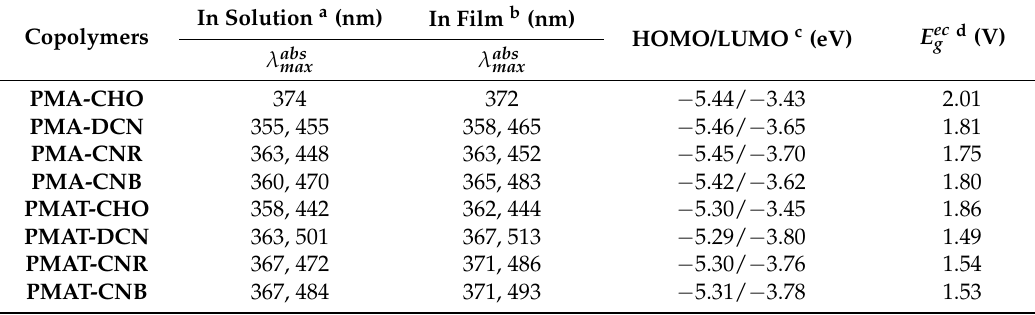
Figure 2. Ultraviolet (UV)-visible absorption spectra of the copolymers ( a ) in toluene solutions and ( b ) in thin films. Table 2. Photophysical and electrochemical properties of